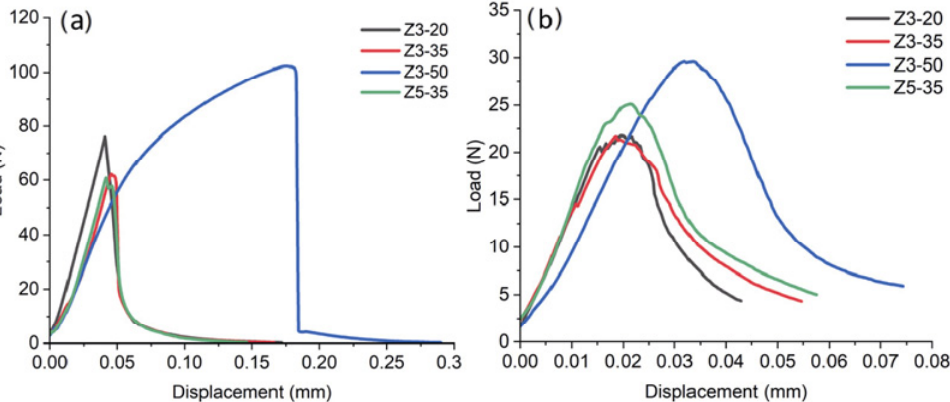
Fig. 8 (a) Load–displacement curves for four-point flexural strength of samples; (b) load–displacement curves for K IC of samples (CNB